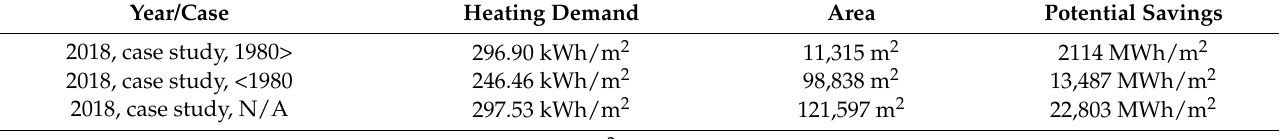
Table 1. Comparison between heating demand in the studied case and the average data for Sweden. Year/Case Heating Demand Area Potential